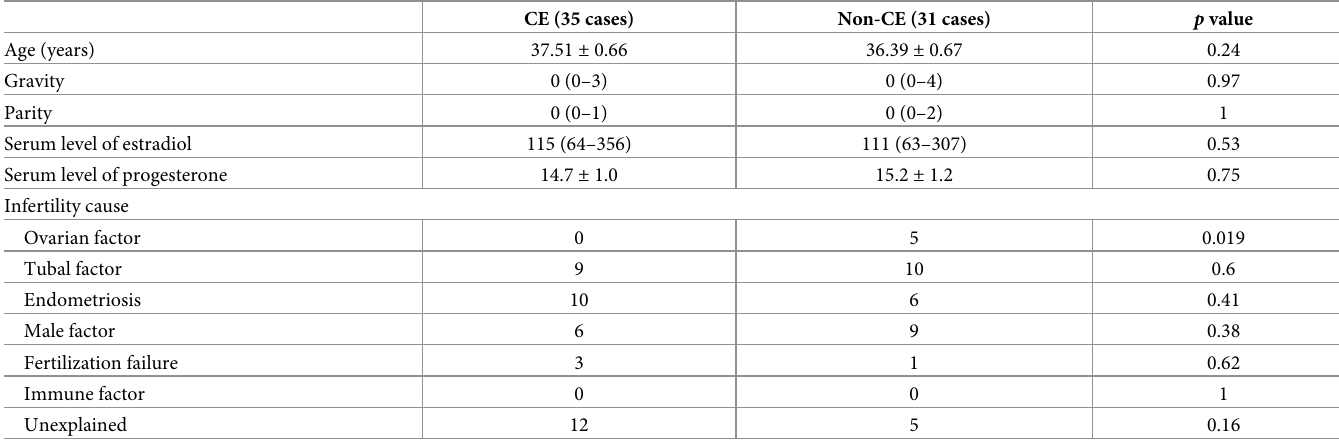
Table 3 summarizes the associations between CE and the expression profiles of Slug and Snail. The expression of Slug in stromal cells was seen in 34 of 35 and 21 of 31 cases in the CE and Non-CE groups, respectively (p = 0.0019) (Fig 2E and 2F). No cases showing the expression of Slug in endometrial glandular cells were present in either group. The cytoplasmic expression of Snail was noted in 28 and 11 cases in the CE and Non-CE groups, respectively (p = 0.004) (Fig 2G and 2H), and the nuclear expression of Snail was seen in 6 and 0 cases, respectively Table 1. Patient characteristics in the CE and Non-CE